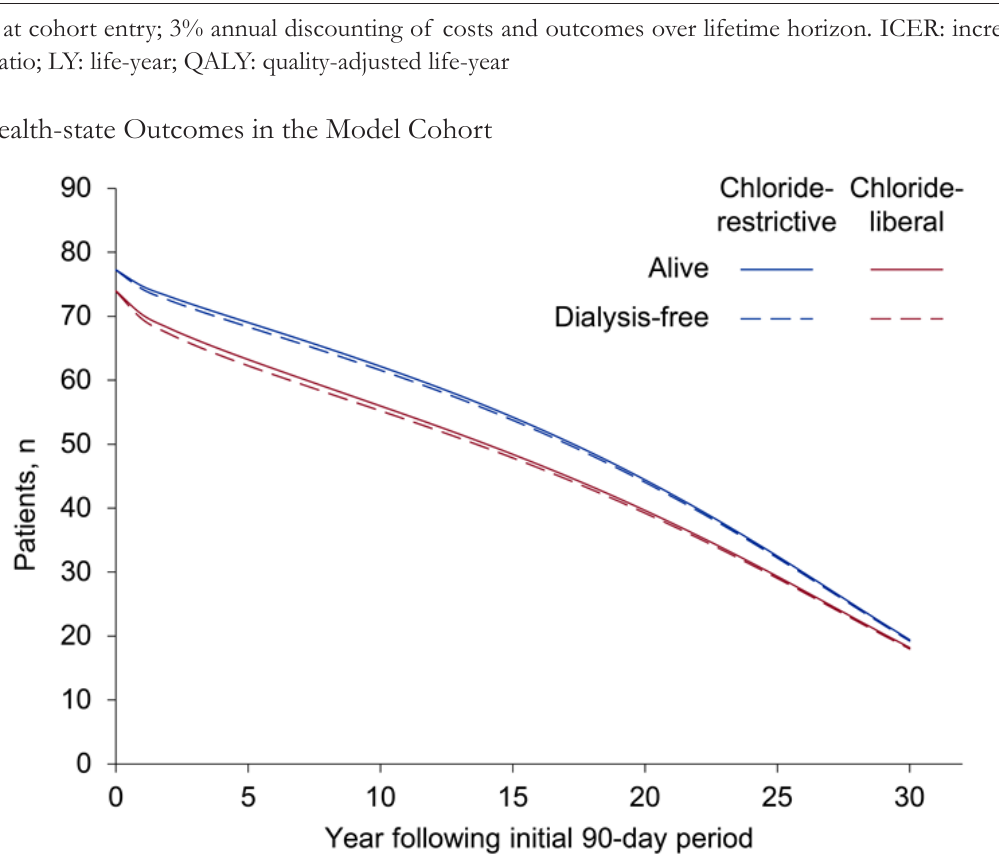
Note: x-axis scale refers to years within the Markov model (i.e., Year 0 begins at the end of the 90-day initial period modeled in the decision